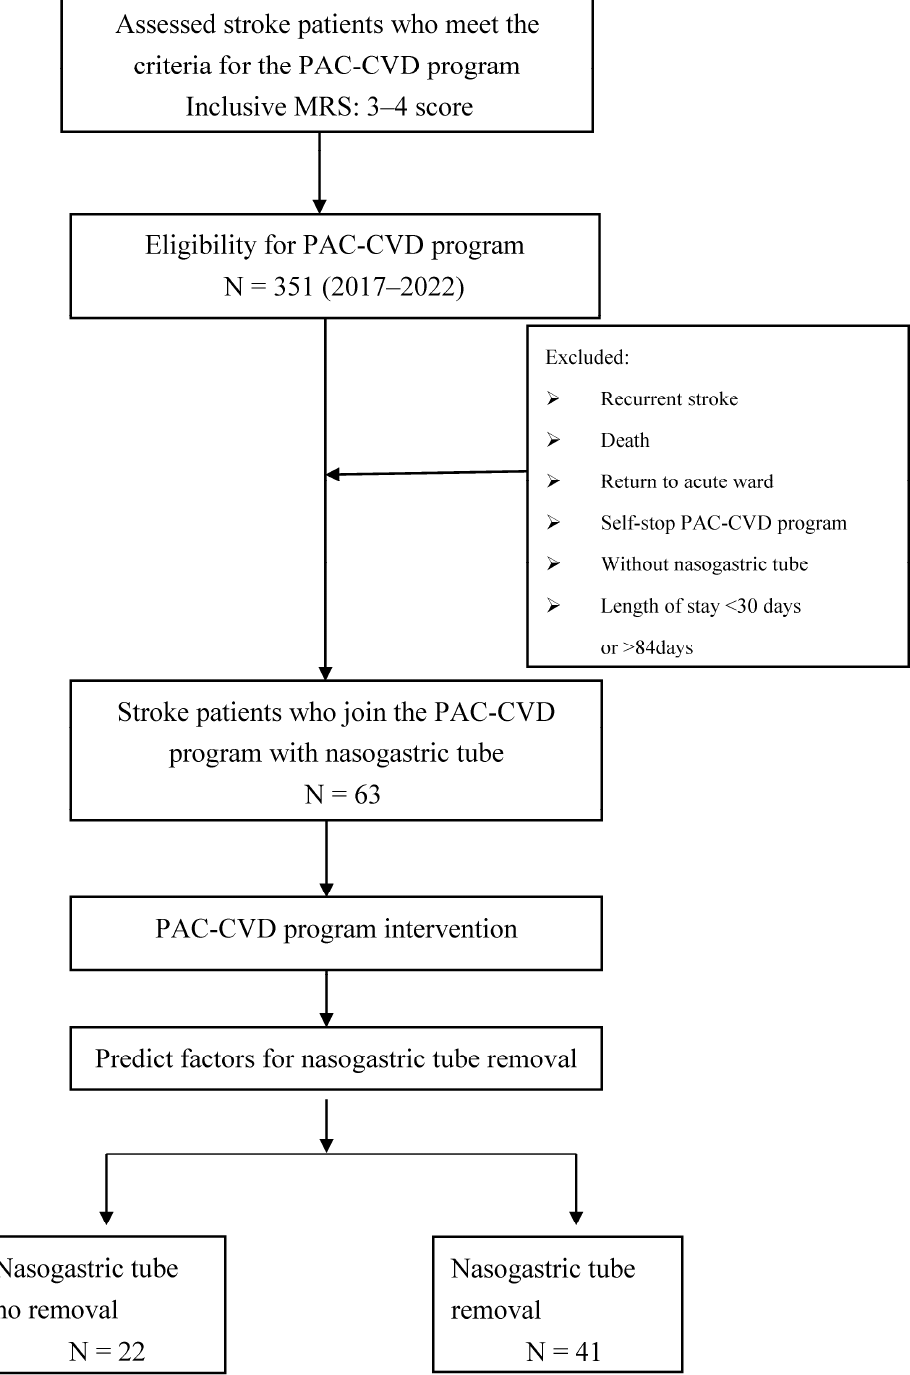
Figure 1. Study flow diagram. MRS, Modified Rankin Scale; PAC-CVD, post-acute care– cerebrovascular disease.